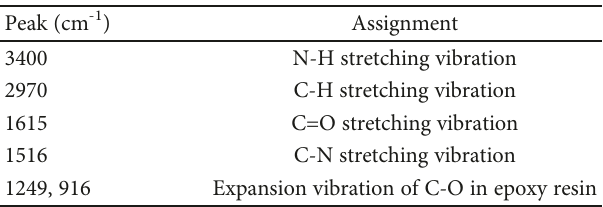
Table 4: Assignment of peaks.